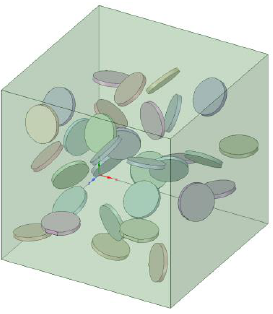
Figure 8. A model of randomly distributed GNPs at a loading of 2% vol.